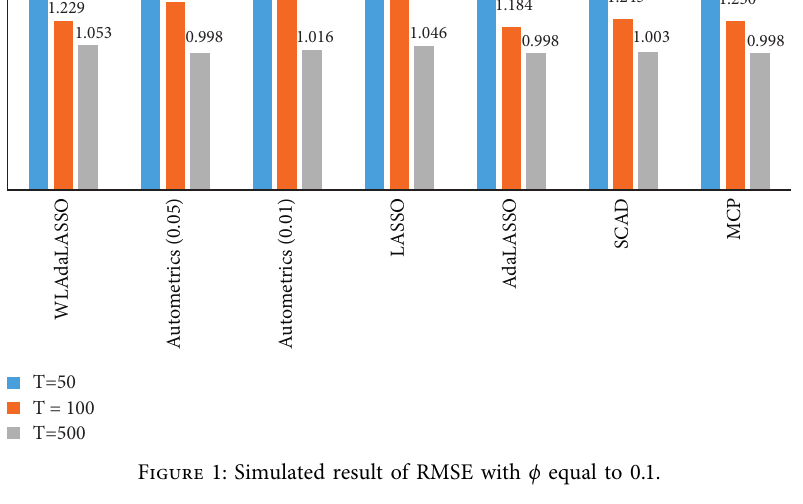
Figure 1: Simulated result of RMSE with ϕ equal to 0.1.